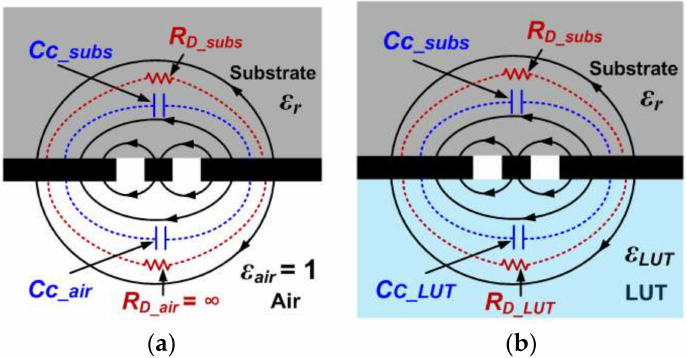
Figure 3. Cross-sectional view of the slot region of the CSRR, with electric field lines and contributions to the total CSRR capacitance and dielectric resistance. ( a ) Empty container; ( b ) full